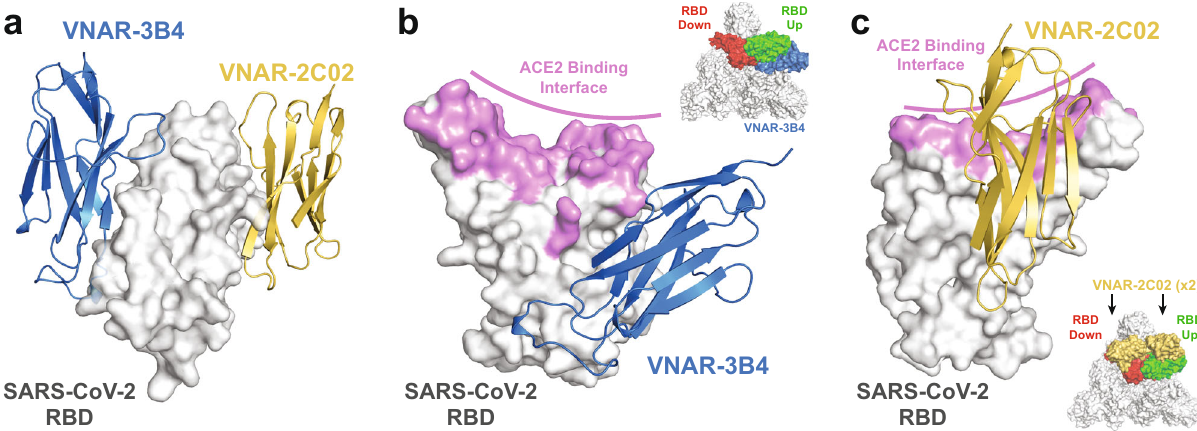
Fig. 2 VNARs 3B4 and 2C02 bind to distinct epitopes on the SARS-CoV-2 RBD. a Transposed structures of VNAR 3B4 (blue) and 2C02 (yellow) complexes aligned to the RBD colored white as a surface representation. b SARS-CoV-2 RBD shown as a surface representation in gray with the ACE2 binding interface colored purple. A cartoon representation of VNAR-3B4 depicted in blue bound to the RBD. Inset shows a surface view of the top of the full-spike trimer with the RBD colored red in the “ RBD-down ” conformation and colored green in the “ RBD-up ” conformation with VNAR-3B4 in blue. c A 180-degree rotation of the SARS-CoV-2 RBD is shown as in Panel A with a cartoon representation of VNAR-2C02 (yellow) bound to the RBD. Inset shows a surface view of the top of the full-spike trimer with the RBD colored as in Panel A with two VNARs colored in